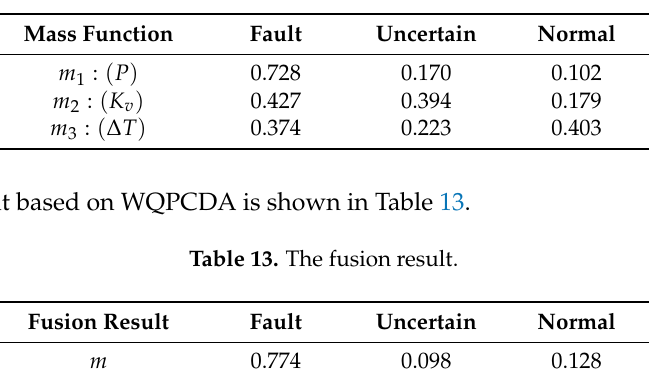
Table 12. The weighted mass functions.